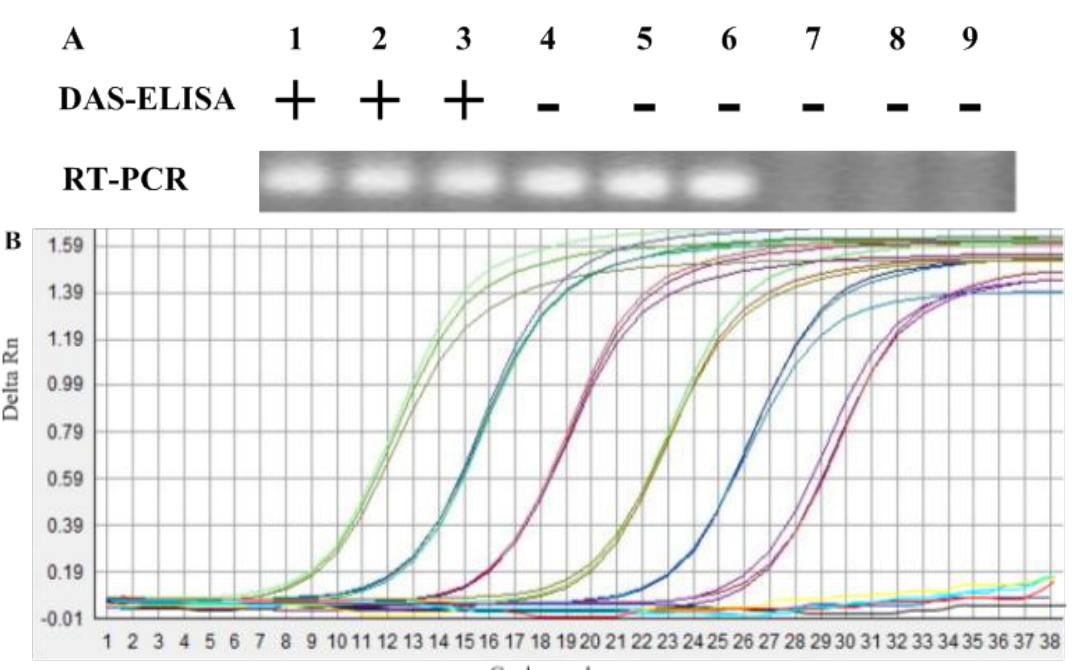
Figure 2. The detection of TMV in plant by the assays of DAS-ELISA ( A ), RT-PCR ( A ) and IC-real-time RT-PCR ( B ). Lanes 1 to 6 are dilutions at 1:10 1 , 1:10 2 , 1:10 3 , 1:10 4 , 1:10 5 and 1:10 6 (1 mL, w/v, per g soil) of naturally TMV-infected leaf saps, respectively, and, Lanes 7 to 9 are the template of ToMV-contaminated soil, TMV-free soil, and healthy leaf extract, respectively. “+” represents positive result of DAS-ELISA for detecting TMV, “−” represents negative result of DAS-ELISA for detecting TMV. (B) Sensitivity of the IC-real-time RT-PCR assay as monitored by amplified curve. Shown from left to right are the curves of decreasing TMV-infected leaf saps at 1:10 1 , 1:10 2 , 1:10 3 , 1:10 4 , 1:10 5 and 1:10 6 (1 mL, w/v, per g soil) dilutions. The curves roughly parallel to the X axis are TMV from ToMV-contaminated soil, TMV-free soil, and healthy leaf extract,